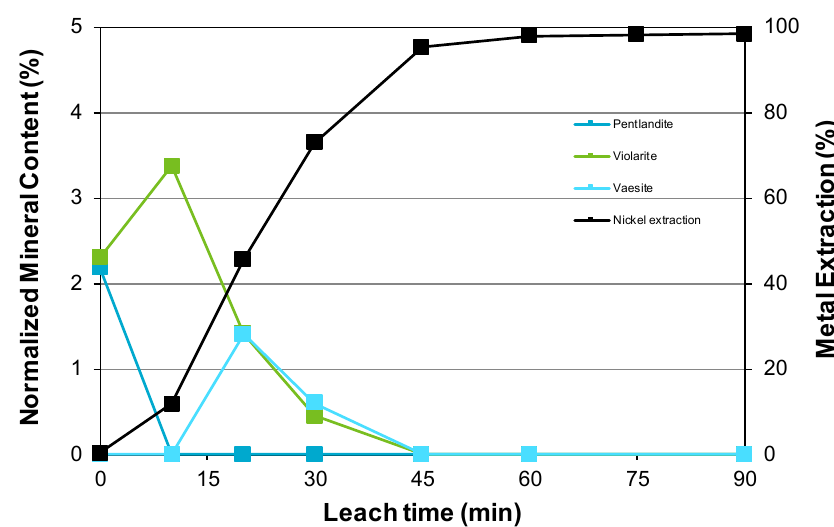
Figure 7. Changes in the composition of nickel sulfide minerals in the leach residue with corresponding nickel extraction for samples taken during the co ‐ processing of 19.5% w/w nickel laterite ore with 10.5% w/w nickel concentrate in site water at 250 °C.